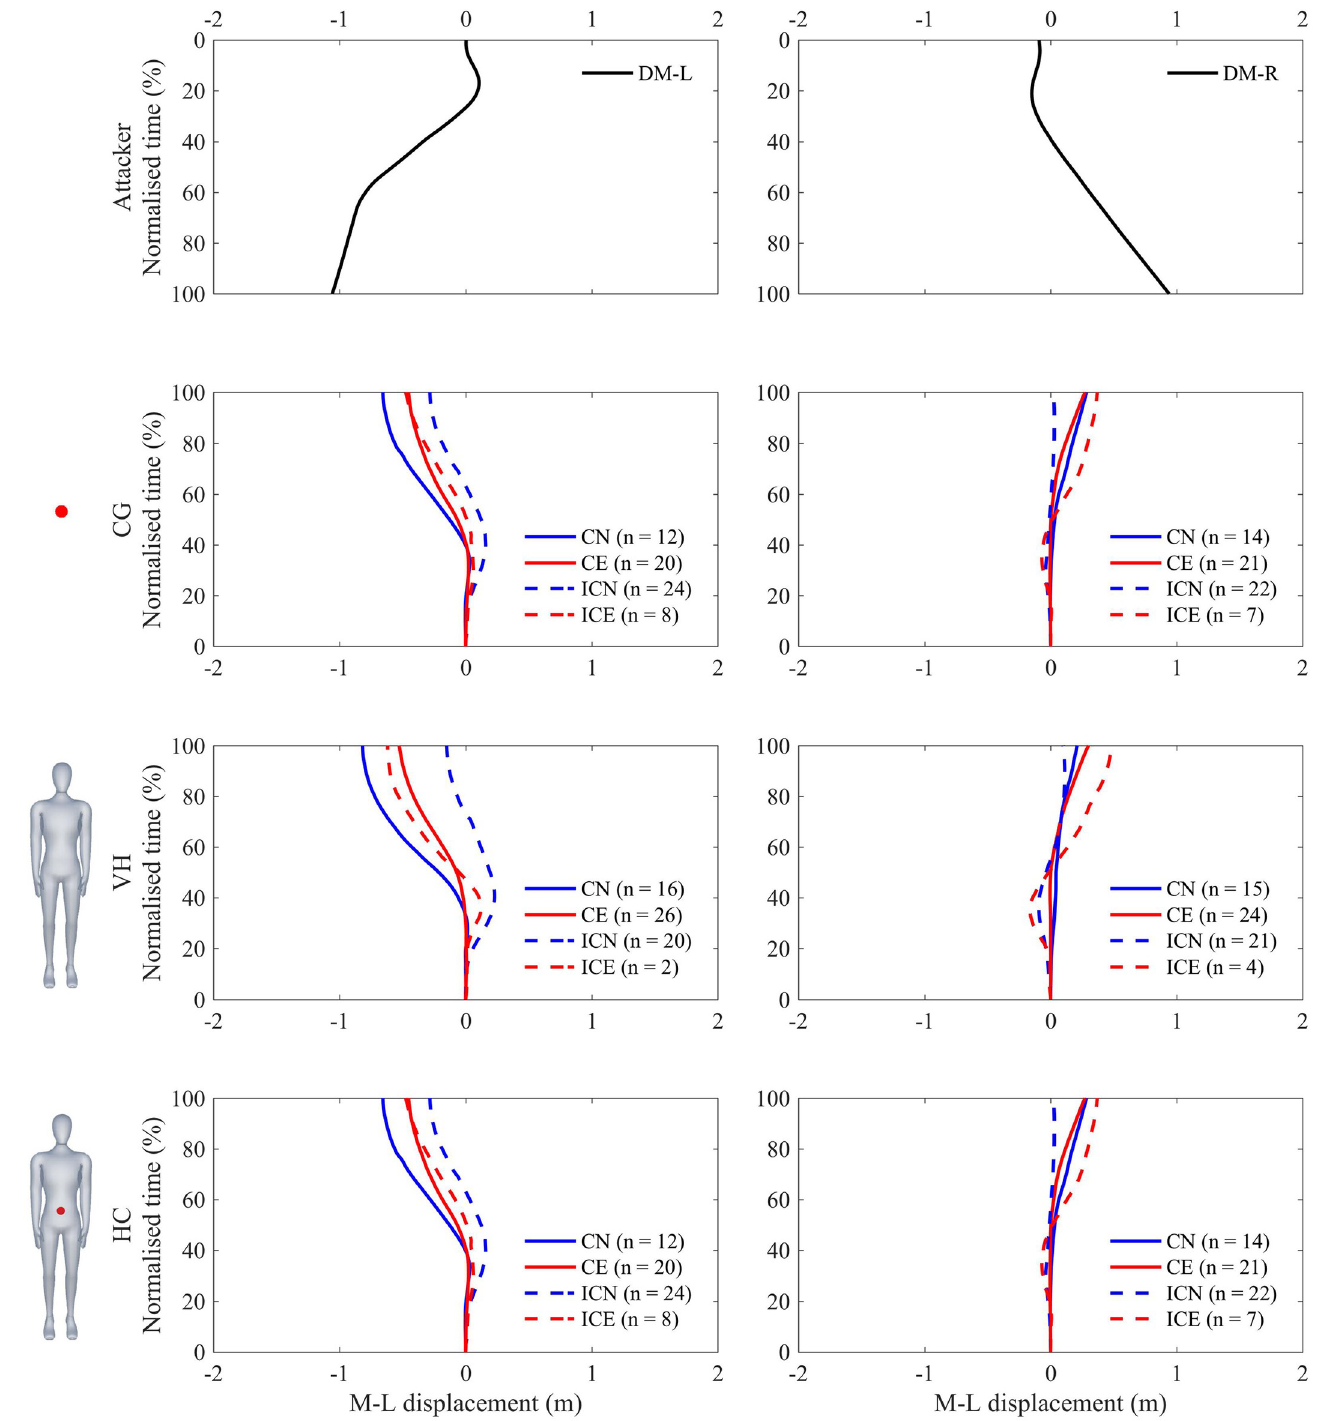
Fig 6. Average medio-lateral response displacement during deceptive motion. Average medio-lateral displacement during normalized time of expert (red) and novice (blue) defenders in successfully (solid line) and unsuccessfully (dashed line) detecting final crossing direction of the attackers motion (top). Columns (left— right) represent the motion of the attacker; DM-L and DM-R, and Rows (top—bottom) represent the visual appearance of the attacker; CG, VH, and